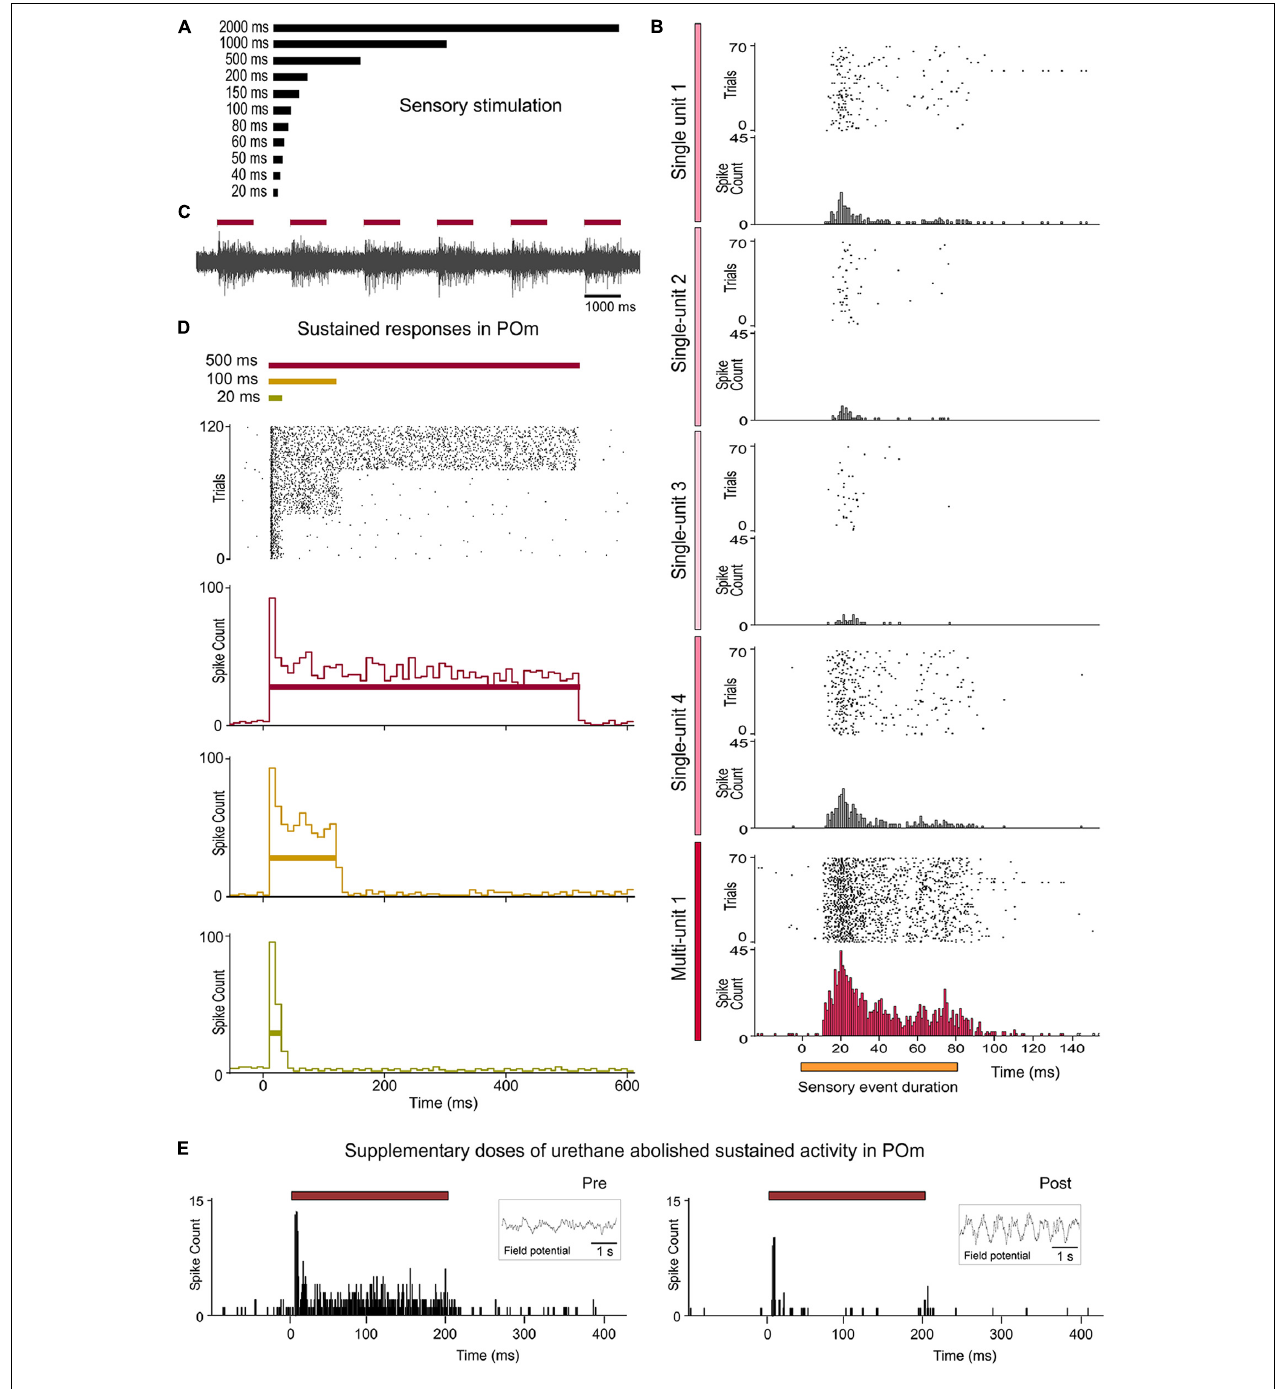
FIGURE 2 | Sustained activity in POm. (A) Air-puffs used for sensory stimulation varied in duration from 20 ms to 2 s. (B) The encoding of the duration of sensory events by POm was studied at single-unit and multi-unit level. Raster plots and PSTHs showing one multi-unit and four single-unit POm responses extracted from the same recording and evoked by a sensory pattern of 80 ms duration. Note that the robustness of this form of encoding by POm sustained activity is obtained from population response formed by the superposition of spikes from individual neurons. The gradual color intensity of vertical lines represents a simulated contribution of each single-unit in this example to the encoding of stimulus duration. (C) Example recording in POm showing evoked sustained activity lasting the duration of the stimulus. (D) POm responds throughout the entire duration of the stimuli. Raster plot and PSTHs (bin width 10 ms) showing sustained multi-unit POm responses evoked by different stimulus duration (40 trials shown for each stimulus). Note that the duration of the stimulus did not alter the onset latency of responses. (E) POm sustained responses were highly affected by the level of anesthesia. They were only observed during the lightly anesthetized state. Supplementary doses of urethane abolished sustained activity in POm. Field potential activity recorded in each condition is shown in the insets. Horizontal color lines indicate the duration of the stimulus. Time 0 indicates the onset of the stimulus.